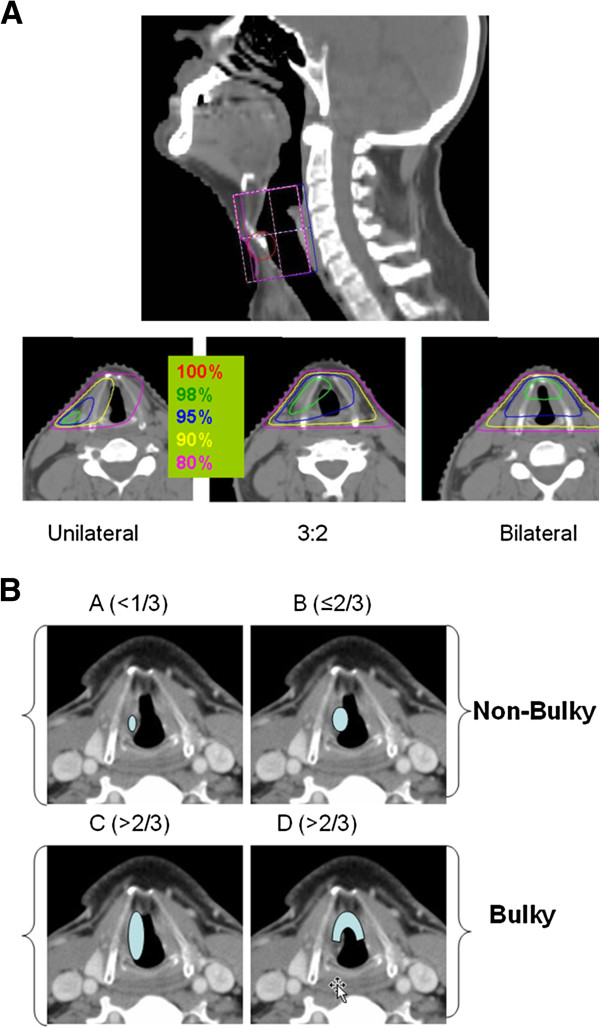
Example of Arrangement & Weighting of Fields (1A) and Comparison of Non- Bulky vs. Bulky Tumor (1B).